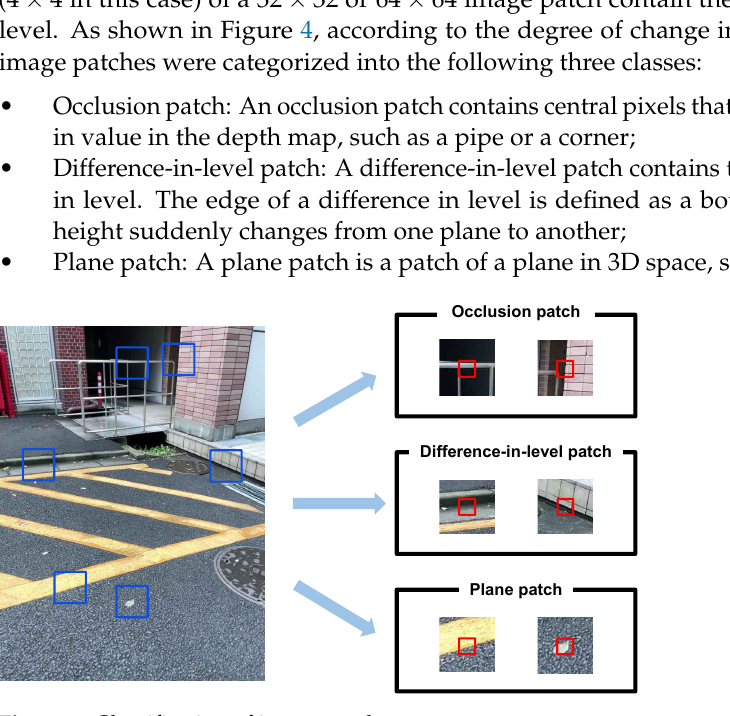
Figure 4. Classification of image